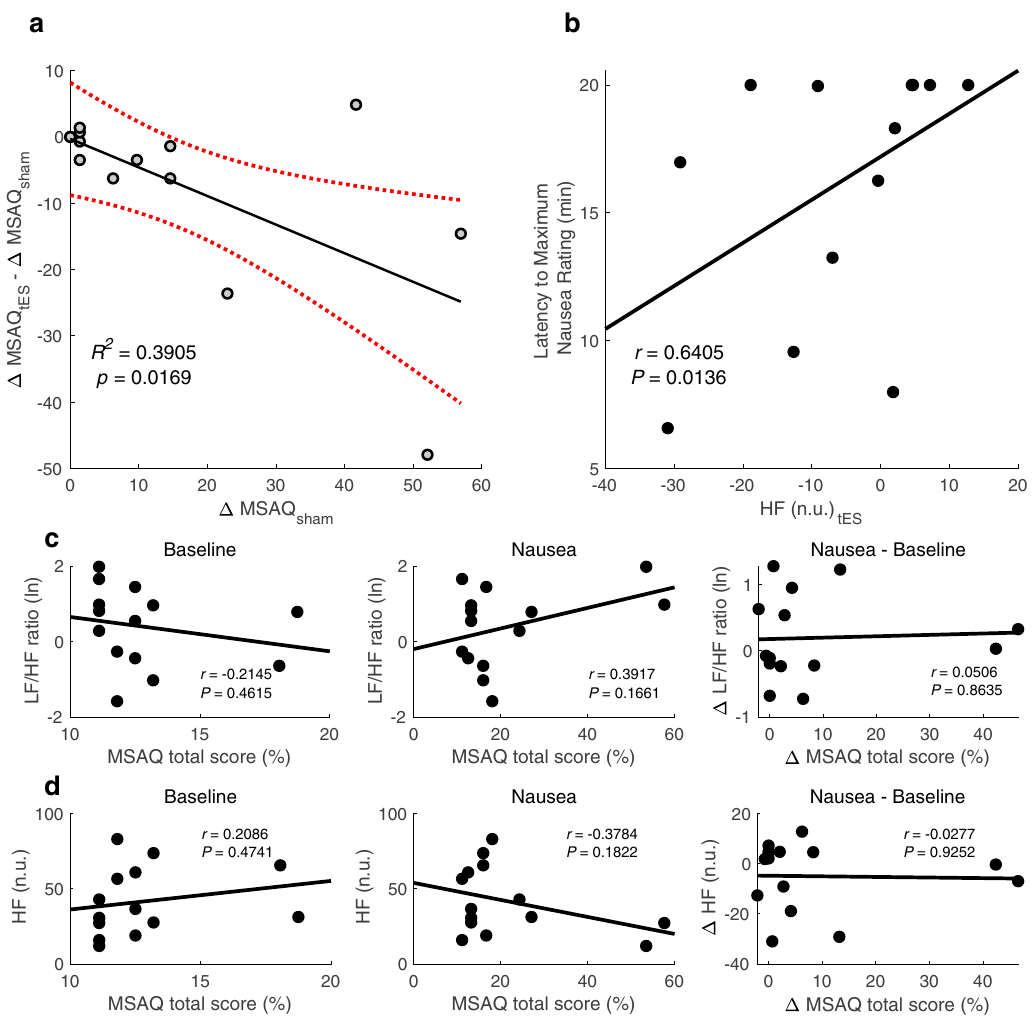
Figure 5. Scatterplots of linear regression, Spearman, and Pearson correlation analysis. (a) A linear regression between MSAQ during sham and the difference between tES and sham condition. (b) A Spearman correlation between HF power during tES condition and the latency to maximum nausea rating. (c) A Pearson correlation between the MSAQ total scores and log-transformed LF/HF ratio at Baseline and during tES as well as the difference between during and before tES intervention. (d) And MSAQ total scores and normalized HF at Baseline and during tES as well as the difference between during and before tES intervention. r , Spearman’s or Pearson’s correlation coefficient ( p -values based on two-tailed statistical